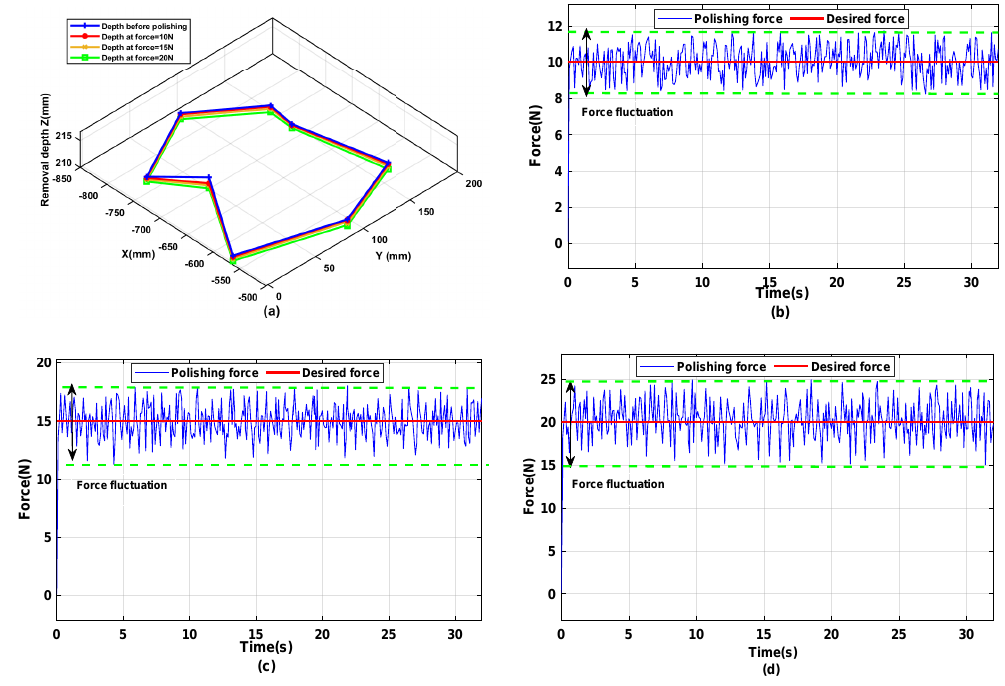
Figure 11. Removal depths and polishing forces ( a ) removal depths at (10, 15, and 20) N ( b ) polishing force at 10 N, ( c ) polishing force at 15 N, and ( d ) polishing force at 20 N. Table 2. Z-axes positions (mm) of path 1 after polished by 10, 15 and 20 N.